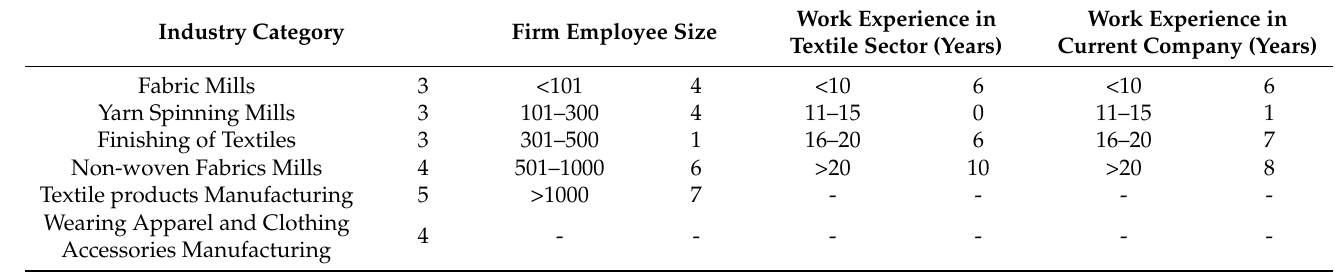
Table 2. Profile of